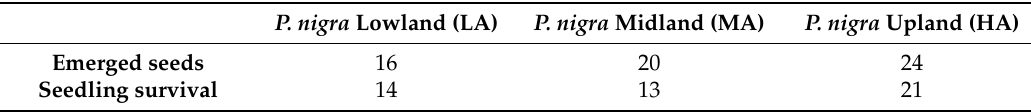
Table 2. Number of emerged seeds and survived seedlings for each experimental condition at the greenhouse experiment. n = 24 seeds by P. nigra seed origin.